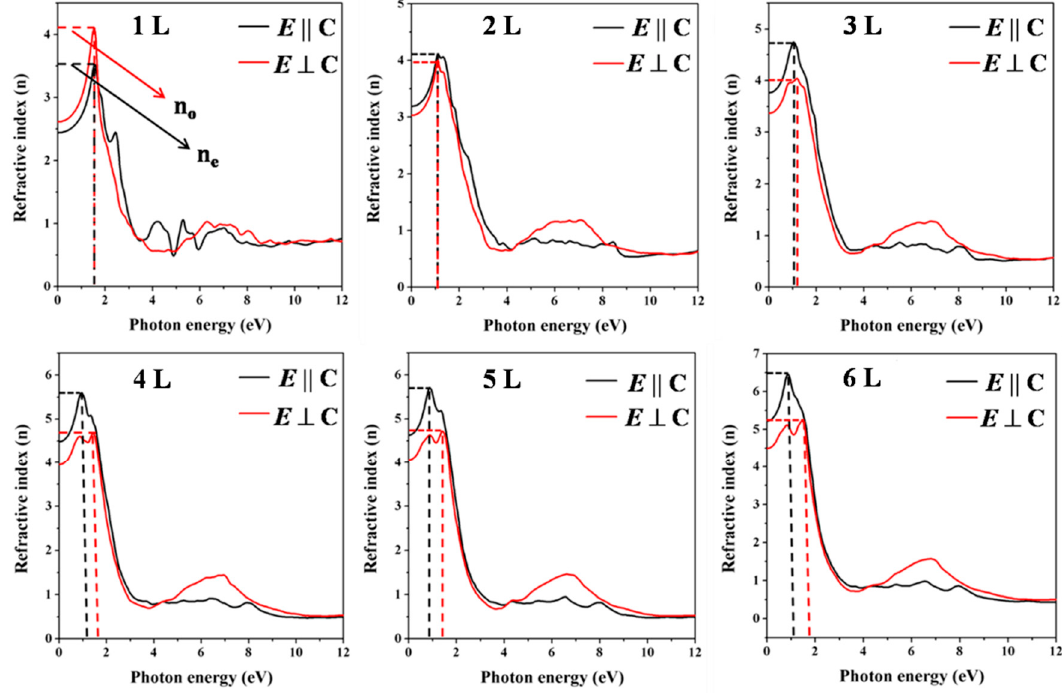
Figure 8. Calculated refractive index along E ⊥ C (n o ) and E || C (n e ) polarization directions of the few-layer Tellurenes.